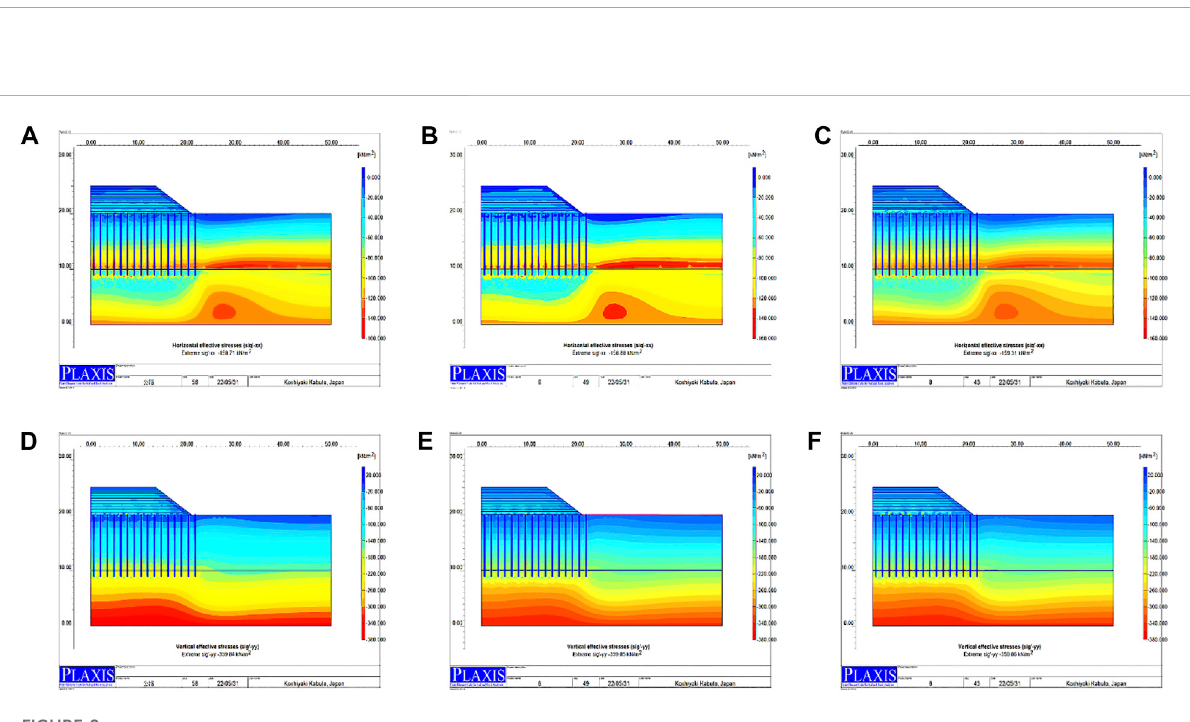
cushion thickness on the vertical settlement and